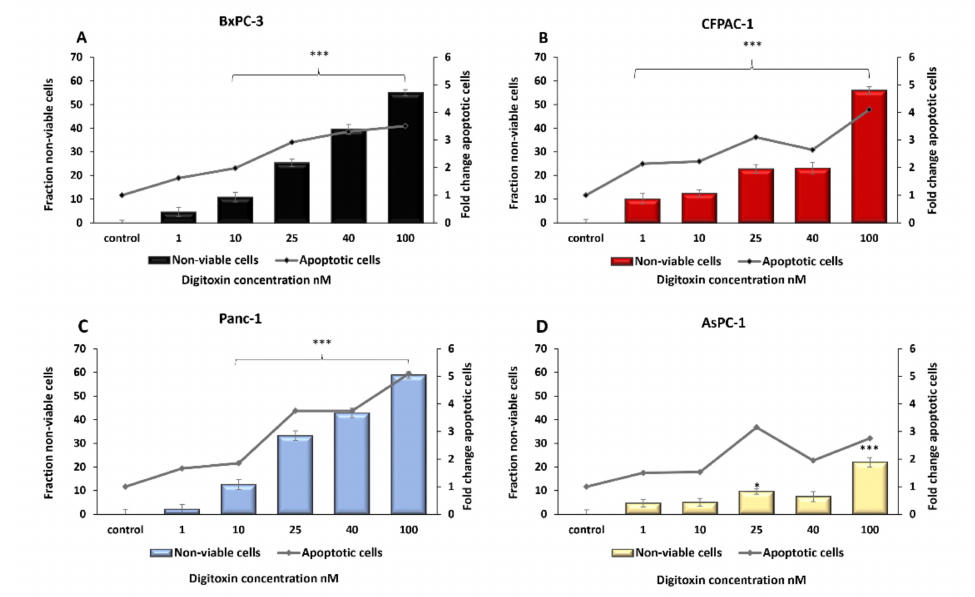
Figure 1. PDAC fraction of non-viable cells (1-MTS) and level of apoptosis (Caspase 3/7) after digitoxin treatment. Cell lines ( A ) BxPC-3, ( B ) CFPAC-1, ( C ) Panc-1, and ( D ) AsPC-1 incubated with digitoxin at concentrations of 1–100 nM for 48 h, with the controls only incubated with complete cell media. The number of viable cells was measured using the MTS assay. Apoptosis was measured using the Caspase 3/7 assay. The fraction of non-viable cells and apoptotic cells for each treatment was normalized to untreated cells (control). Error bars = SEM, Student’s t -test * p ≤ 0.05, and *** p ≤ 0.001.